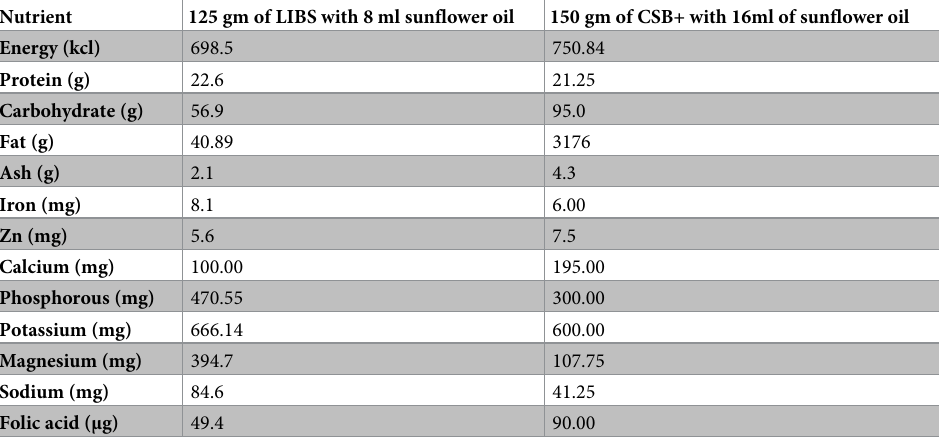
Table 1. Nutrient composition of the supplementary foods.